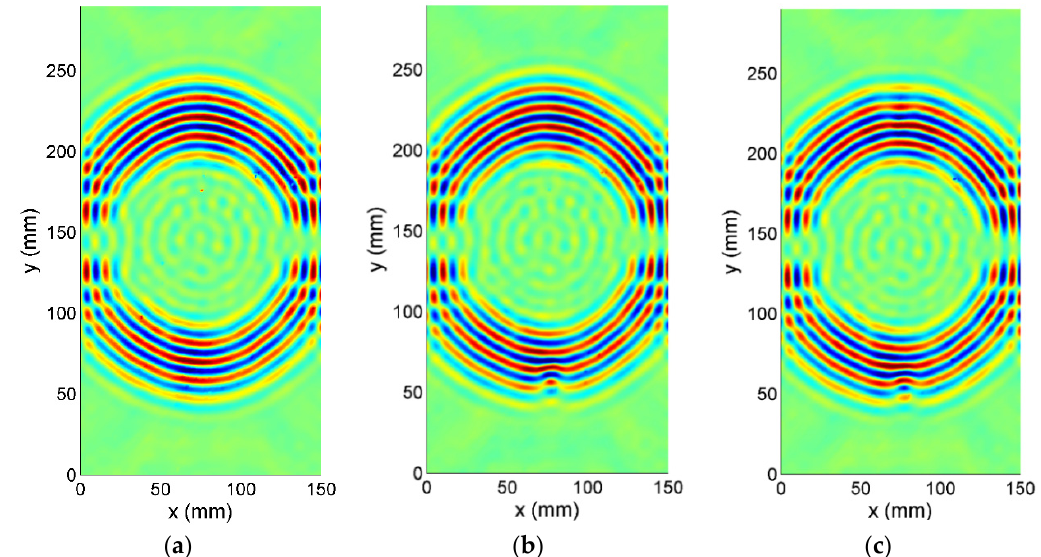
Figure 11. Full wavefield images in space–space domain captured at t = 108 µs: ( a ) pristine condition;